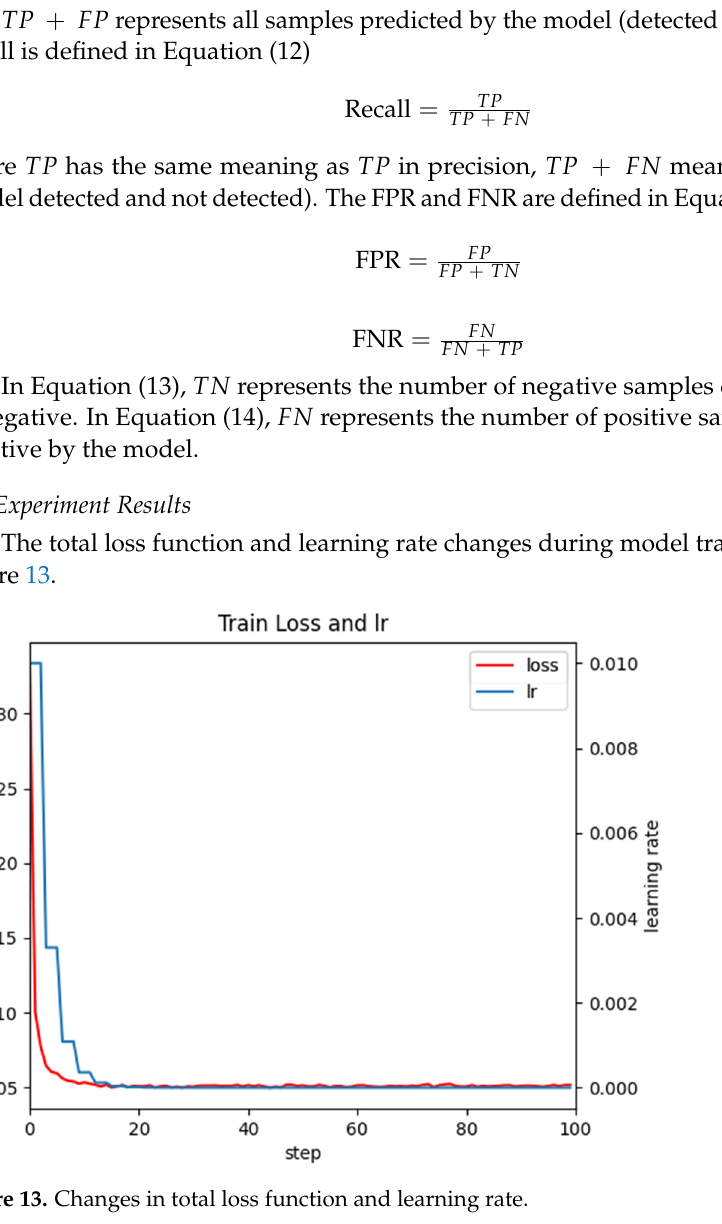
Figure 13. Changes in total loss function and learning rate.